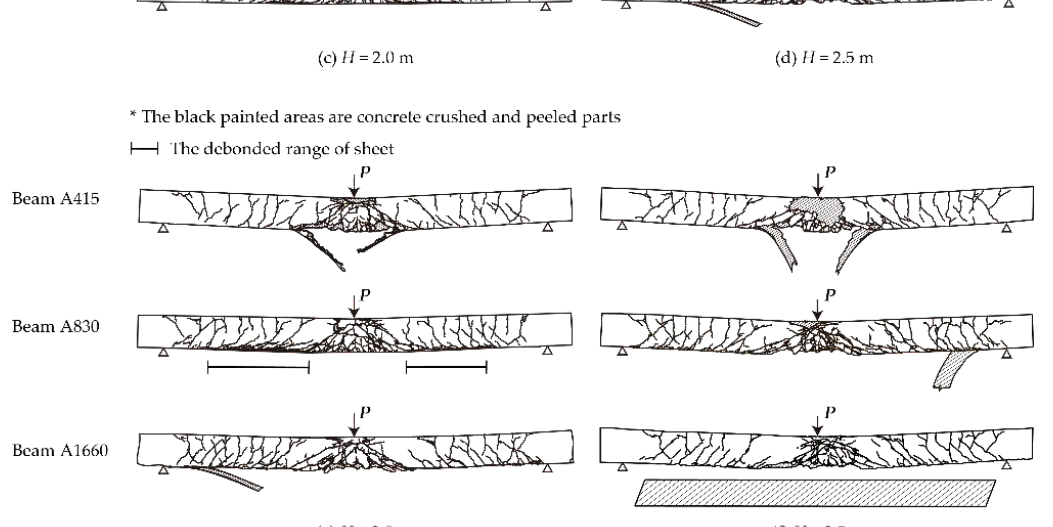
Figure 13. Crack distribution of each beam after the impact loading test.